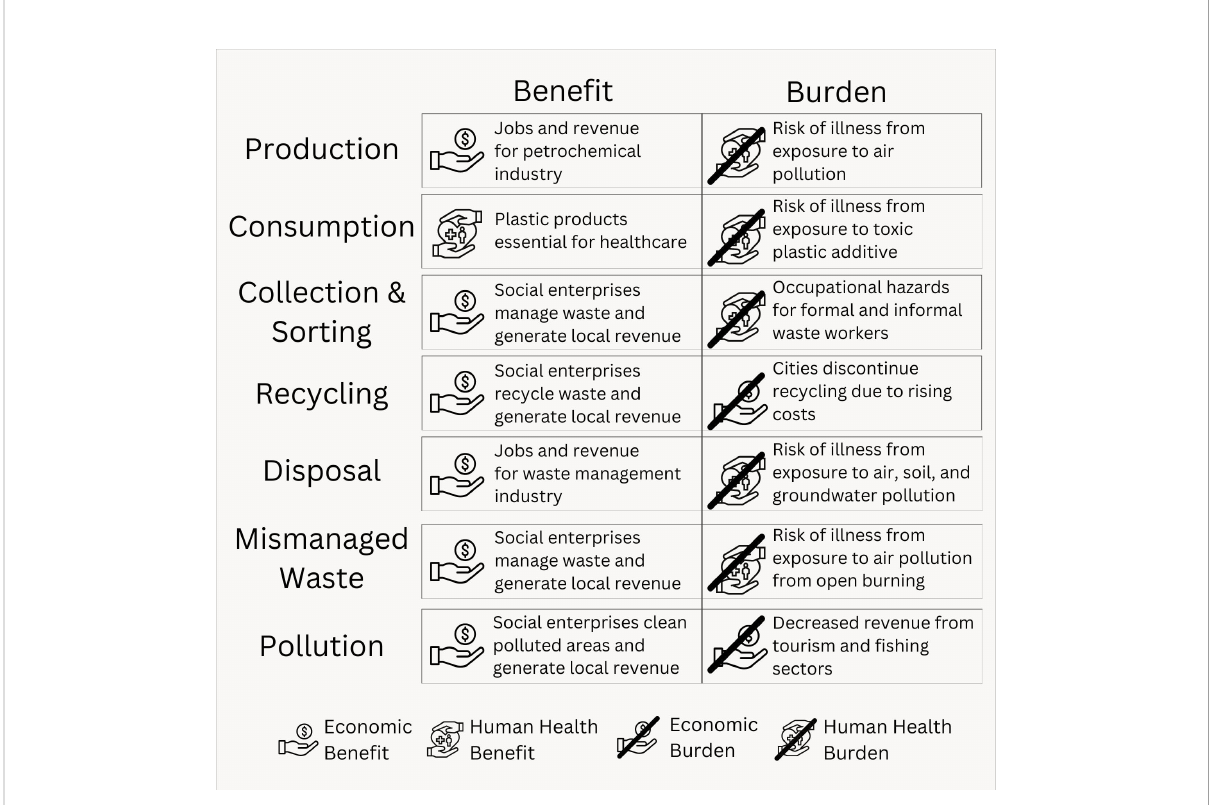
FIGURE 2 Example bene fi ts and burdens across the macroplastic lifecycle. puchongart and WiStudio